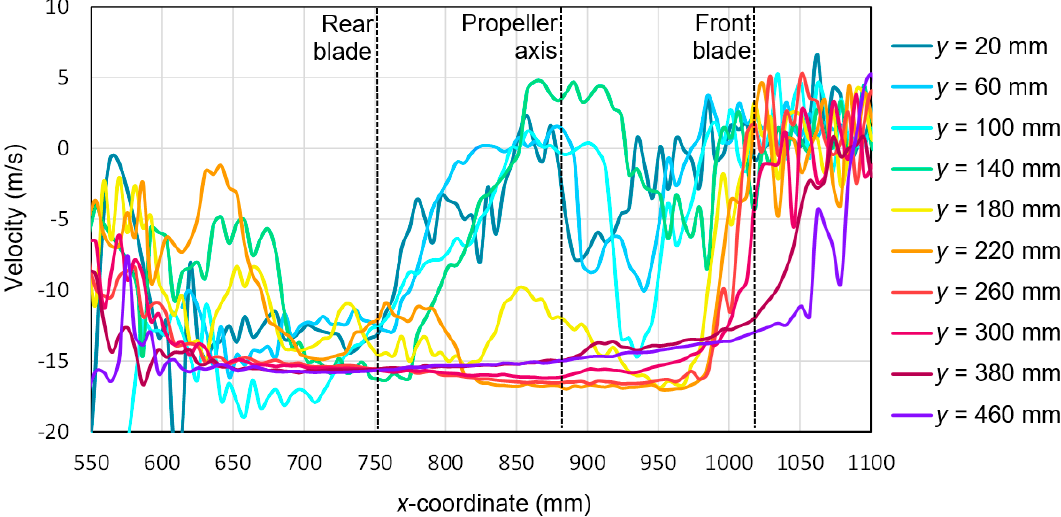
Figure 21. Horizontal components of the airflow velocities around the research object for the following configuration: angle of attack α = − 12° and airflow in the wind tunnel v wt = 12.5 m/s.